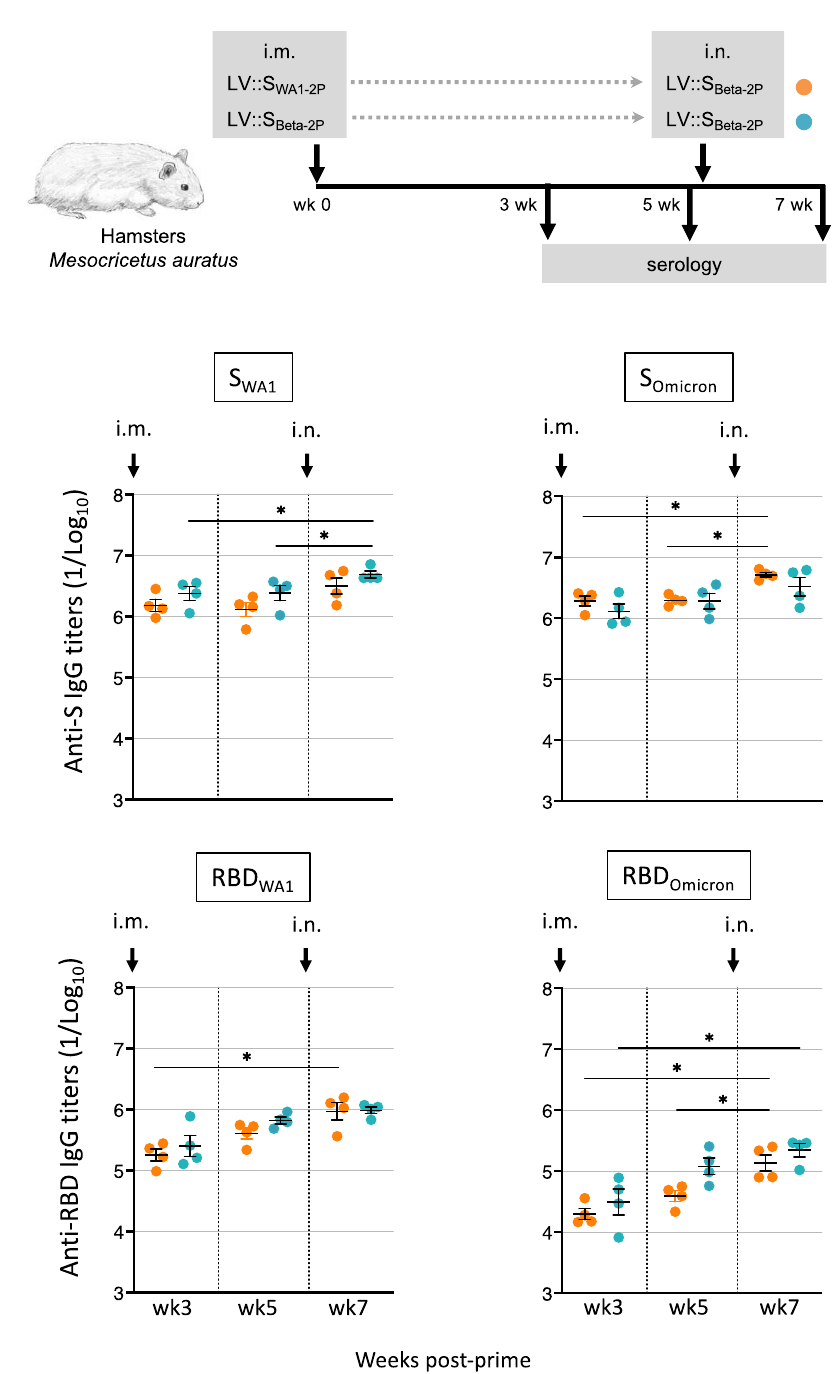
Figure 7. Robust humoral responses in hamsters vaccinated by LV::S WA1-2P or LV::S Beta-2P prime (i.m.)-LV::S Beta-2P boost (i.n.). ( A ) Timeline of prime-boost vaccination. Hamsters ( n = 4/group) were primed i.m. with 1 × 10 8 TU of LV::S WA1-2P or LV::S Beta-2P . Five weeks later, hamsters were boosted i.n. with the same amount of LV::S Beta-2P . ( B ) Serum anti-S WA1 or -RBD WA1 (left panels) or anti-S Omicron or -RBD Omicron (right panels) IgG responses, expressed as the mean endpoint dilution titers ± SEM, determined by ELISA. Statistical differences are indicated by asterisks. * p < 0.05.